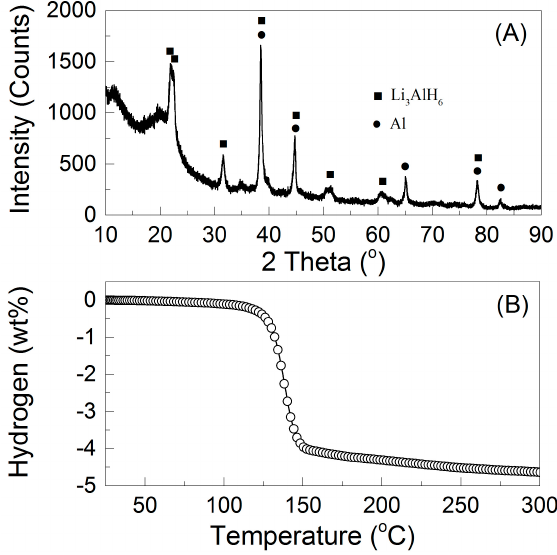
Figure 1. ( A ) XRD pattern and ( B ) Non ‐ isothermal dehydrogenation of the as ‐ prepared Li 3 AlH 6 sample.